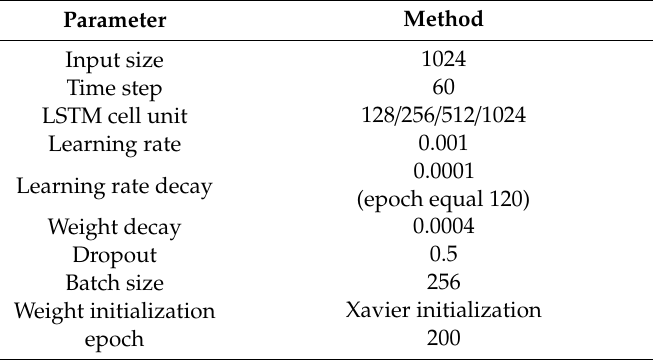
Table 3. Training parameters of LSTM.